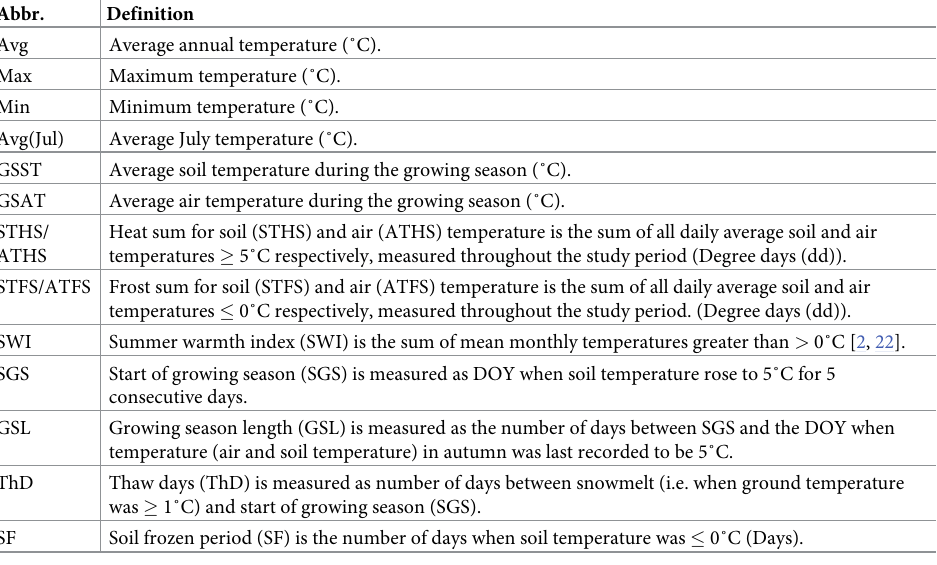
Table 1. Overview of soil and air temperature variables, with abbreviations and measurement units used in the context of this study. Abbr. Definition Avg Average annual temperature (˚C). Max Maximum temperature (˚C). Min Minimum temperature (˚C). Avg(Jul) Average July temperature (˚C). GSST Average soil temperature during the growing season (˚C). GSAT Average air temperature during the growing season (˚C). STHS/ Heat sum for soil (STHS) and air (ATHS) temperature is the sum of all daily average soil and air ATHS temperatures � 5˚C respectively, measured throughout the study period (Degree days (dd)). STFS/ATFS Frost sum for soil (STFS) and air (ATFS) temperature is the sum of all daily average soil and air temperatures � 0˚C respectively, measured throughout the study period. (Degree days (dd)). SWI Summer warmth index (SWI) is the sum of mean monthly temperatures greater than > 0˚C [2, 22]. SGS Start of growing season (SGS) is measured as DOY when soil temperature rose to 5˚C for 5 consecutive days. GSL Growing season length (GSL) is measured as the number of days between SGS and the DOY when temperature (air and soil temperature) in autumn was last recorded to be 5˚C. ThD SF